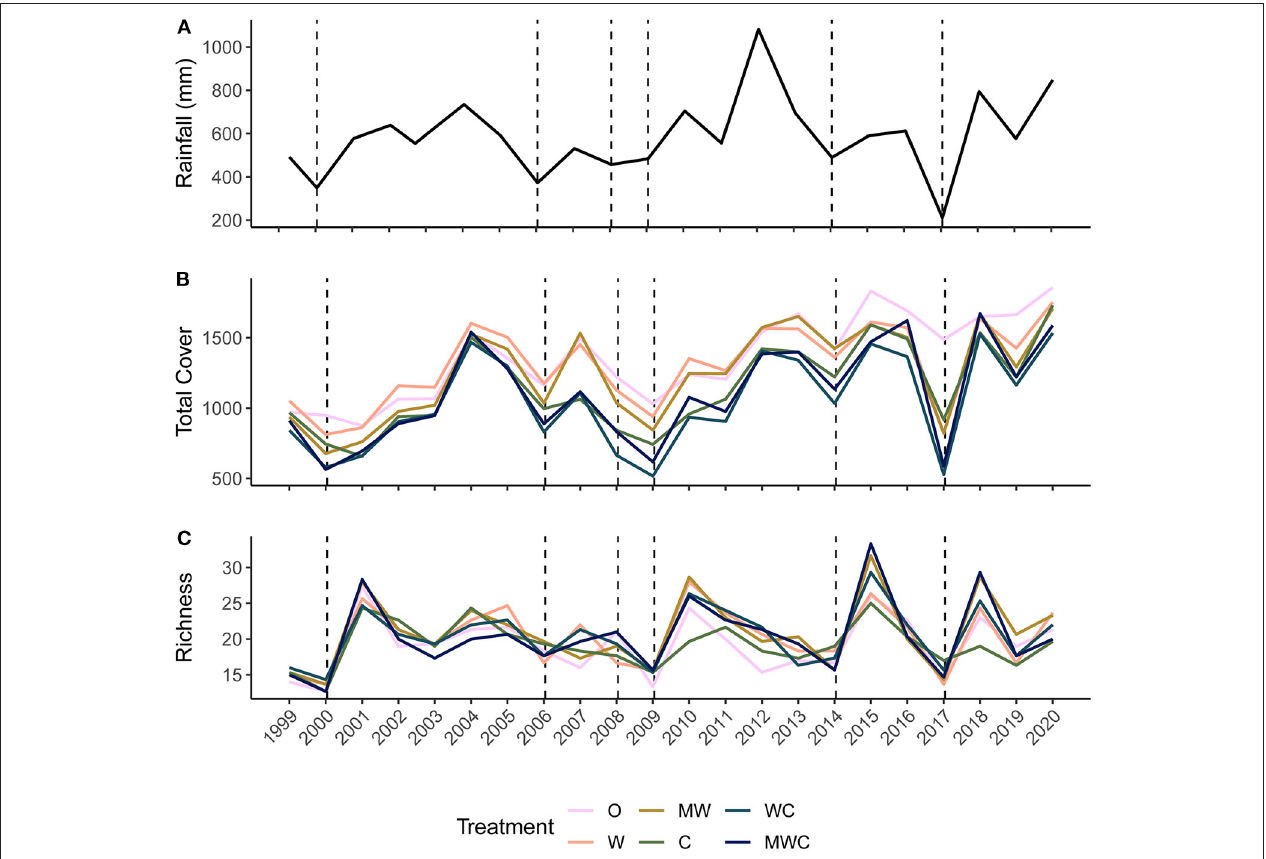
FIGURE 2 | Precipitation (mm) calculated over the 12-months before the annual June sampling period (A) , mean total cover (B) and species richness (C) at each sampling point (annually in June) from 1999-2020 colored by herbivore treatment. Herbivore treatments (ordered by total herbivore biomass) are: O, No herbivores; W, Wild mesoherbivores; MW, Wild megaherbivores and wild mesoherbivores; C, Cattle; WC, Wild mesoherbivores and cattle; MWC, Wild megaherbivores, wild mesoherbivores, and cattle. Dashed lines indicate low rainfall ( < the 25th percentile, defined here as a drought) in the 12 months preceding the sampling